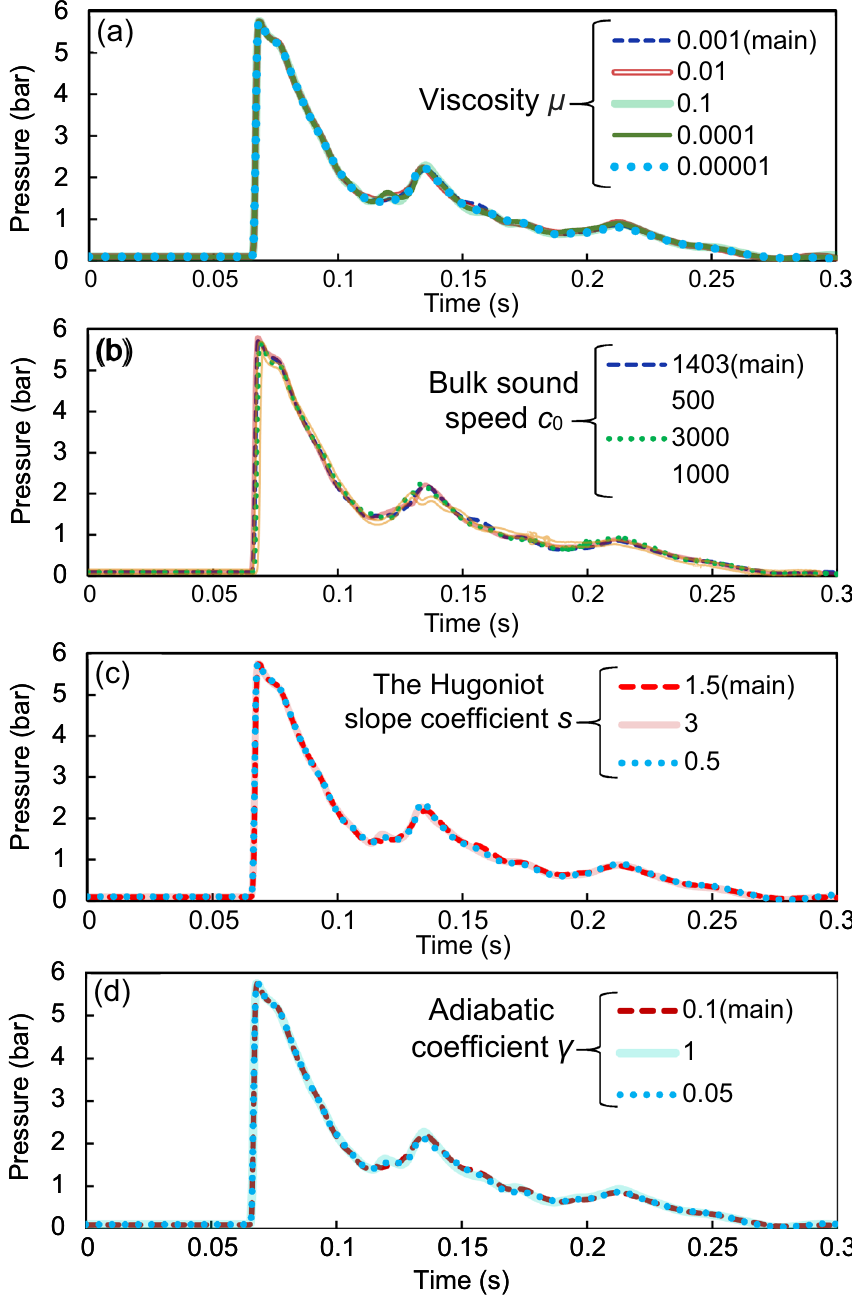
Figure 13. Pressure–time diagrams of model W-2000-20-0.15@20 as a function of various properties of water: ( a ) viscosity μ , ( b ) bulk sound speed c 0 , ( c ) the Hugoniot slope coefficient s , and ( d ) adiabatic coefficient γ